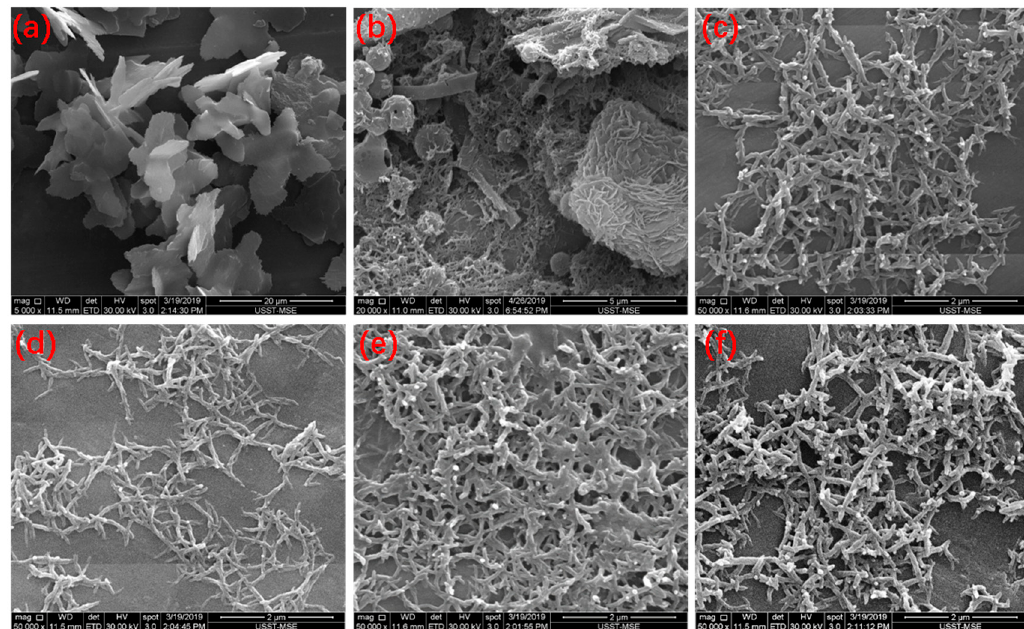
Figure 3. SEM micrographs of PANIs. ( a ) PANI-0.1H; ( b ) PANI-0.3H; ( c ) PANI-1H; ( d ) PANI-1:0.17; ( e ) PANI-1:0.3; ( f ) PANI-1:1.